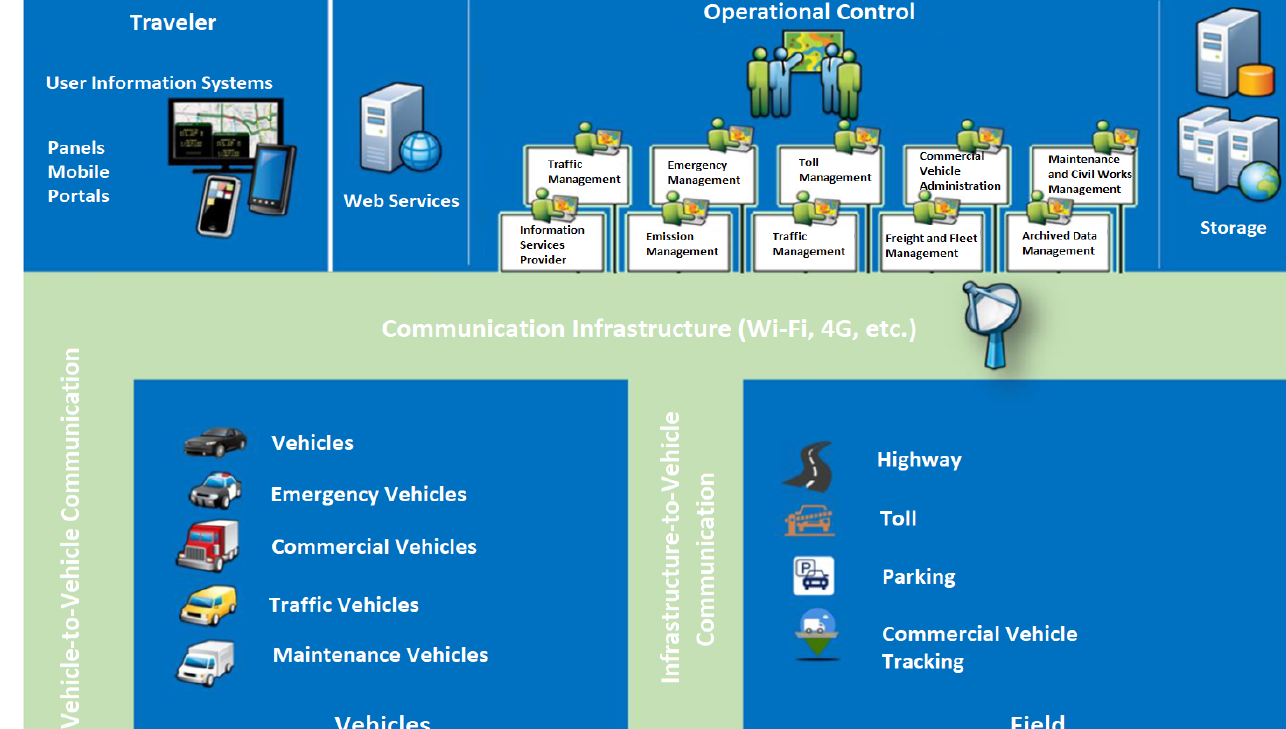
Fig. 8. Brazilian ITS communication infrastructure. Adapted from